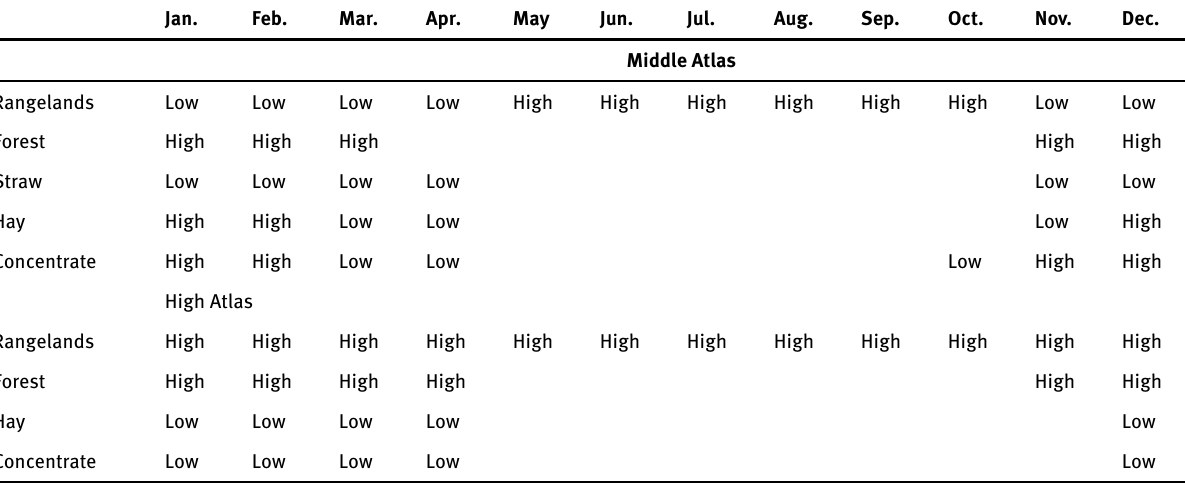
Table 3: Typical feeding calendar of small ruminants raised in